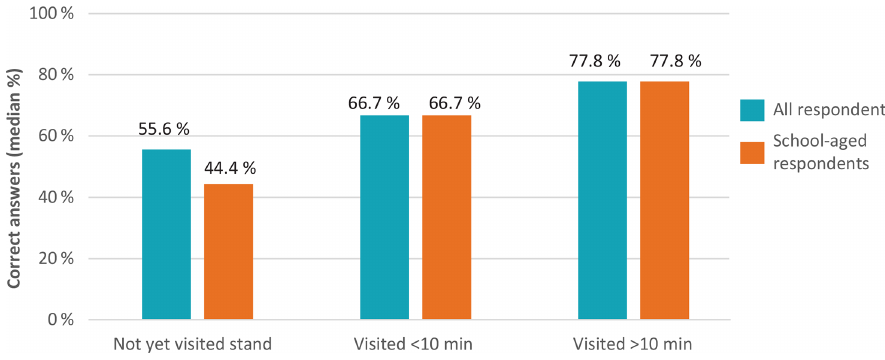
Figure 7. Median quiz scores.